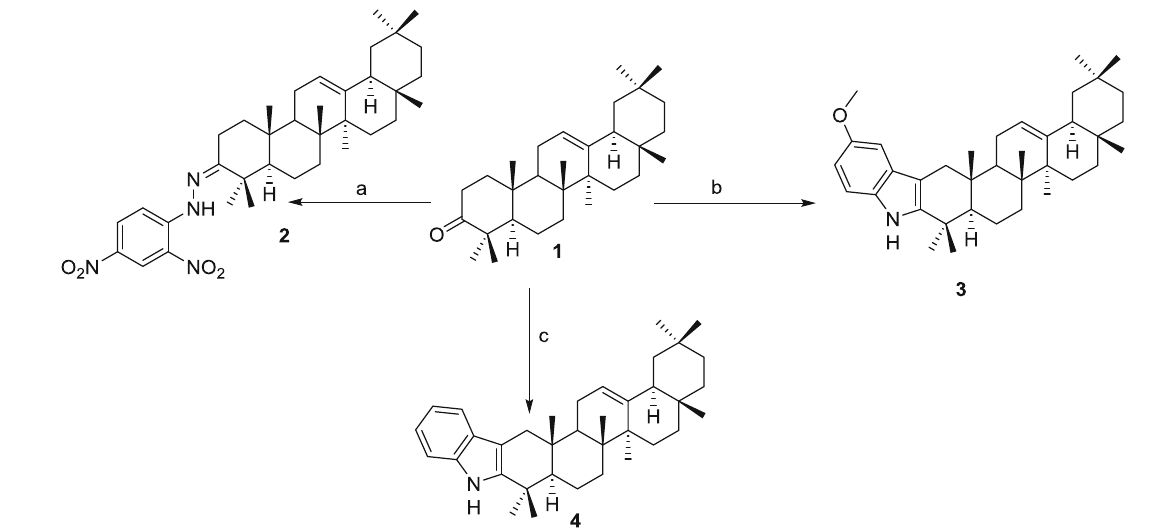
Scheme 1 Schematic representation for the synthesis of compounds 2-4 . Reagents: a reflux, Dichloromethane (DCM)/MeOH, TFA,